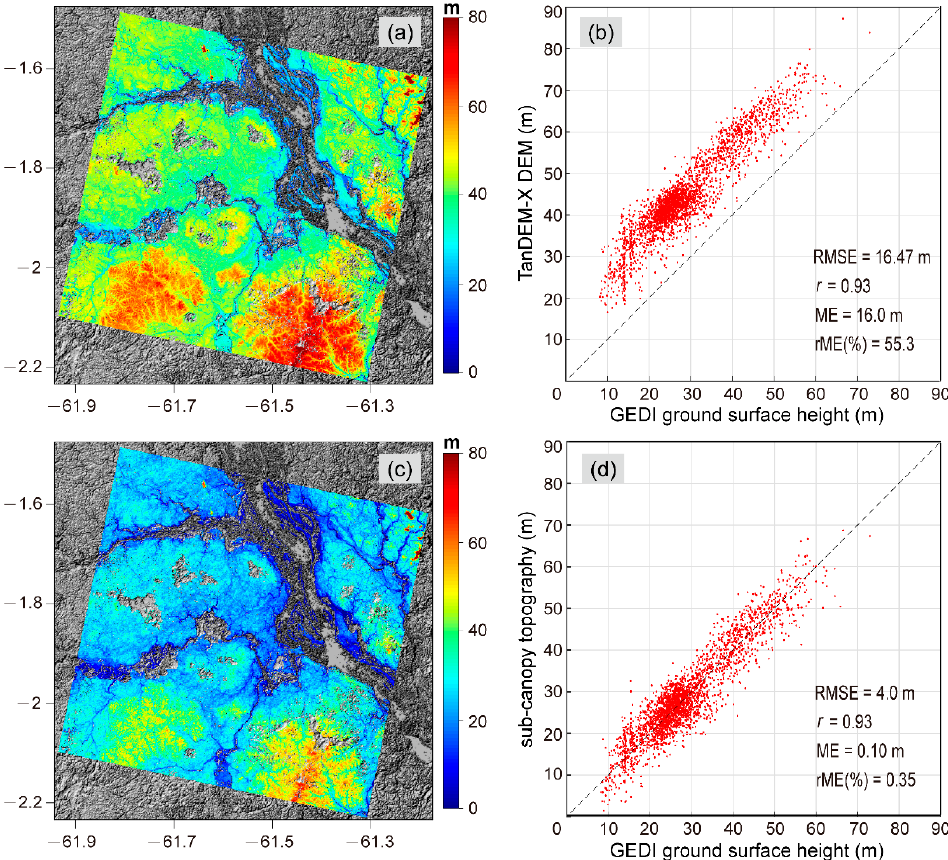
Figure 7. ( a ) Original TanDEM-X DEM; ( b ) Scatterplot comparison between the original TanDEM-X DEM and the GEDI ground surface elevation; ( c ) Sub-canopy topography; ( d ) Scatterplot comparison between the sub-canopy topography and the GEDI ground surface elevation.